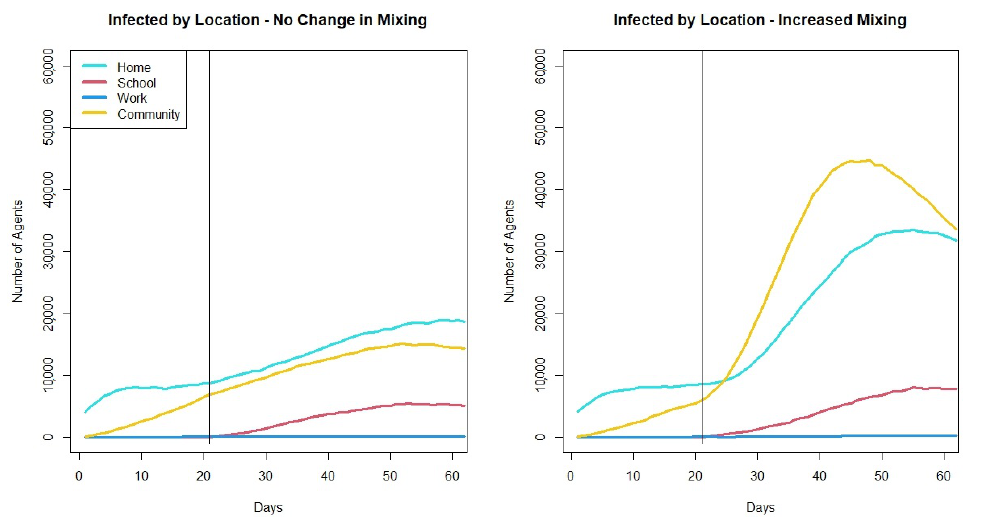
Figure 7. Plot showing average number of infectious agents at a given time based on their location of infection across 30 runs of the two mixing scenarios.